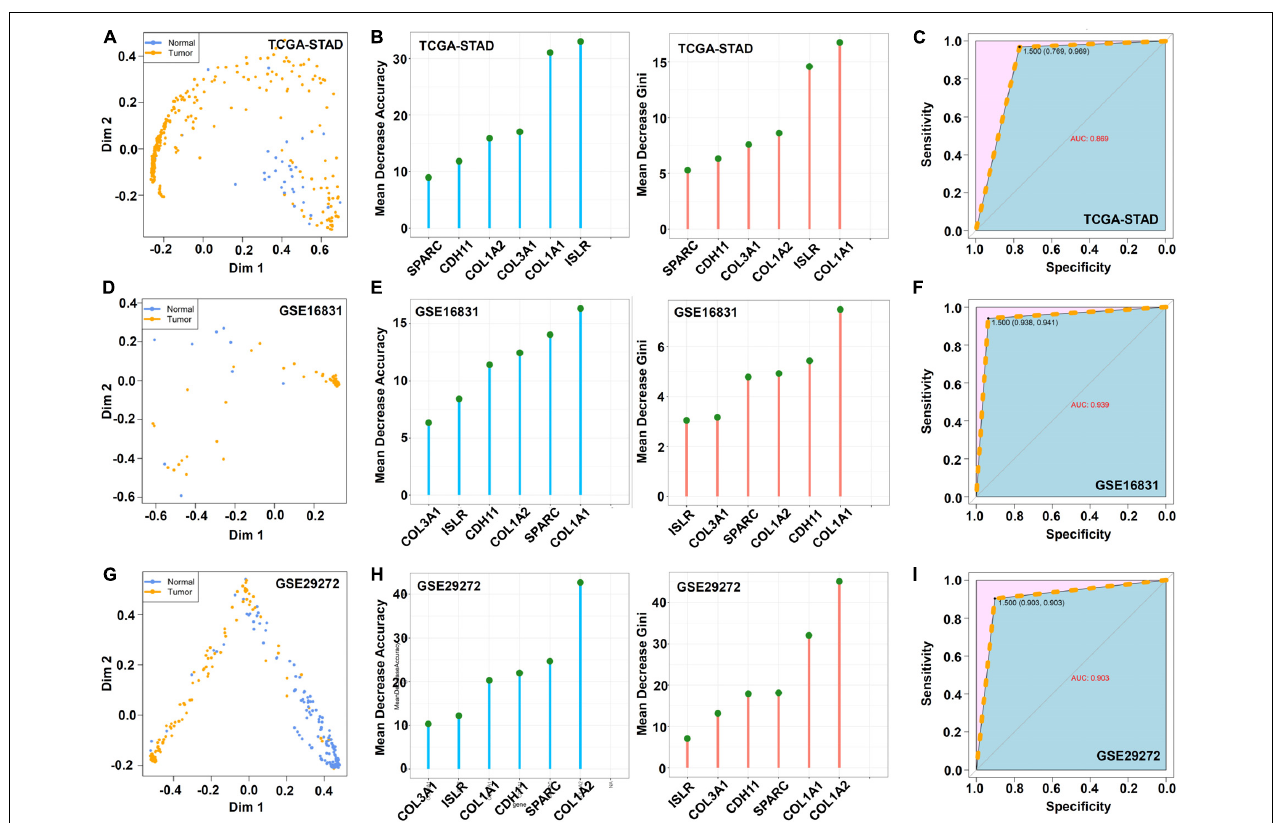
FIGURE 9 | Random forest analysis. Based on the above hub genes, the “randomForest” package (ntree = 500) was utilized for the random forest modeling analysis. The MDSplot () function was used to obtain a multidimensional scale (A,D,G) . The data of mean decrease accuracy and mean decrease Gini were visualized by the ggdotchart () function in the “ggpubr” package (B,E,H) . The receiver operating characteristic (ROC) curve was plotted by the “pROC” package, and the area under the ROC curve (AUC) value was calculated (C,F,I)